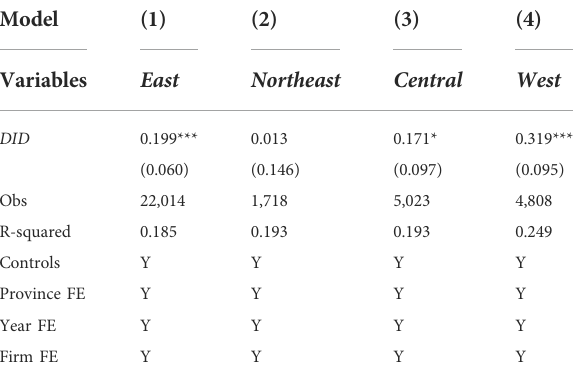
TABLE 10 Ownership heterogeneity estimation results. TABLE 11 Regional heterogeneity estimation